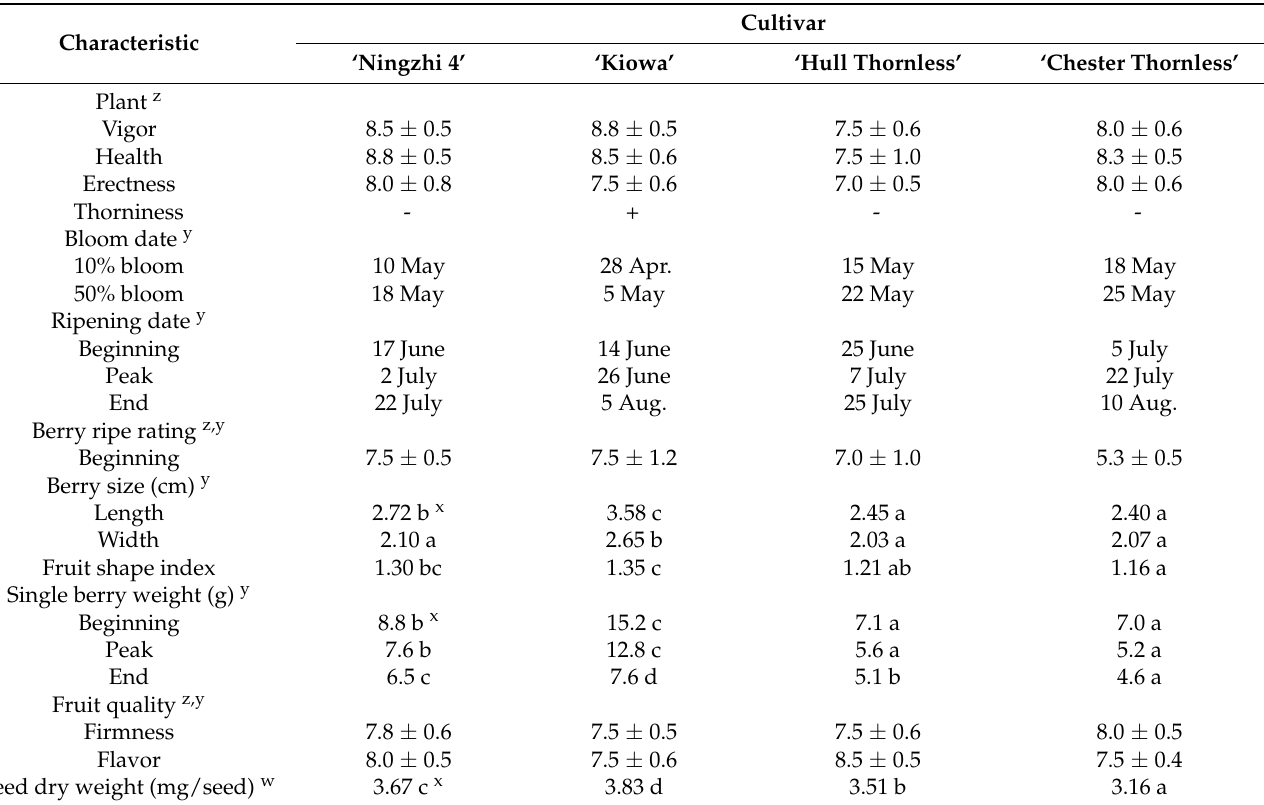
Table 1. Growth habit, phenological phase and fruit characteristics of four blackberry cultivars at Nanjing and/or Lishui in